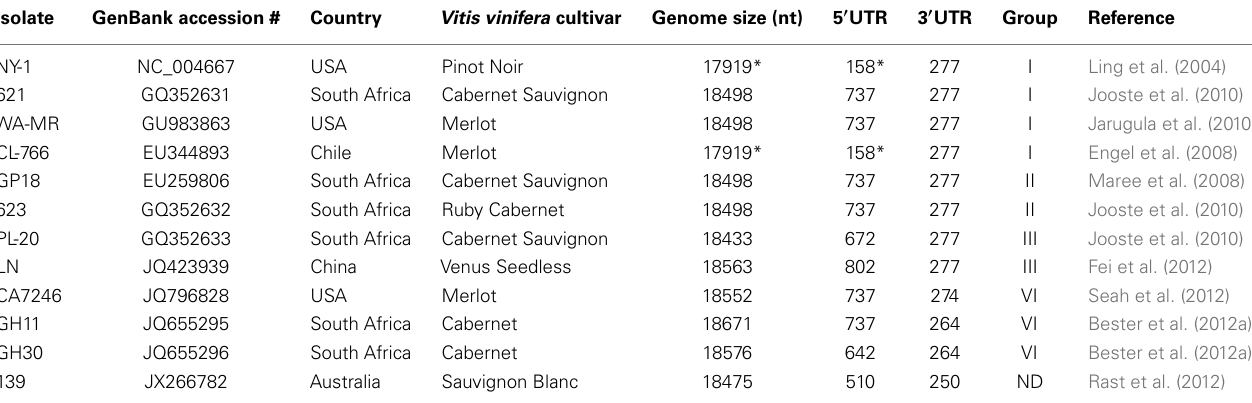
Table 2 | Complete and near complete genomes of GLRaV-3.